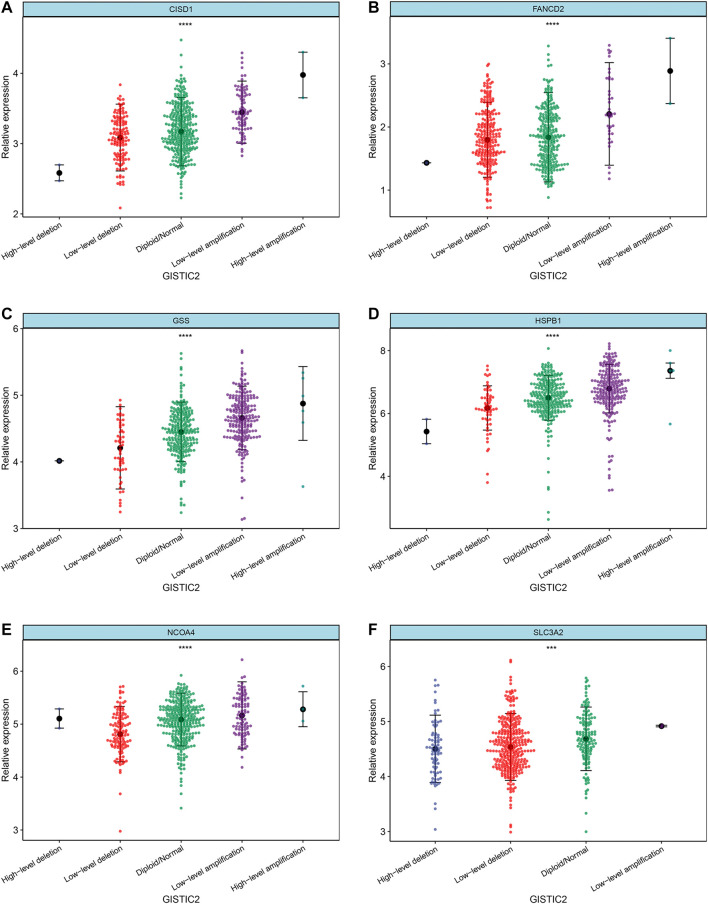
Correlation between copy number variation and mRNA expression of ferroptotic regulators, including (A) CISD1, (B) FANCD2, (C) GSS, (D) HSPB1, (E) NCOA4, and (F) SLC3A2. ***p < 0.001; ****p < 0.0001.